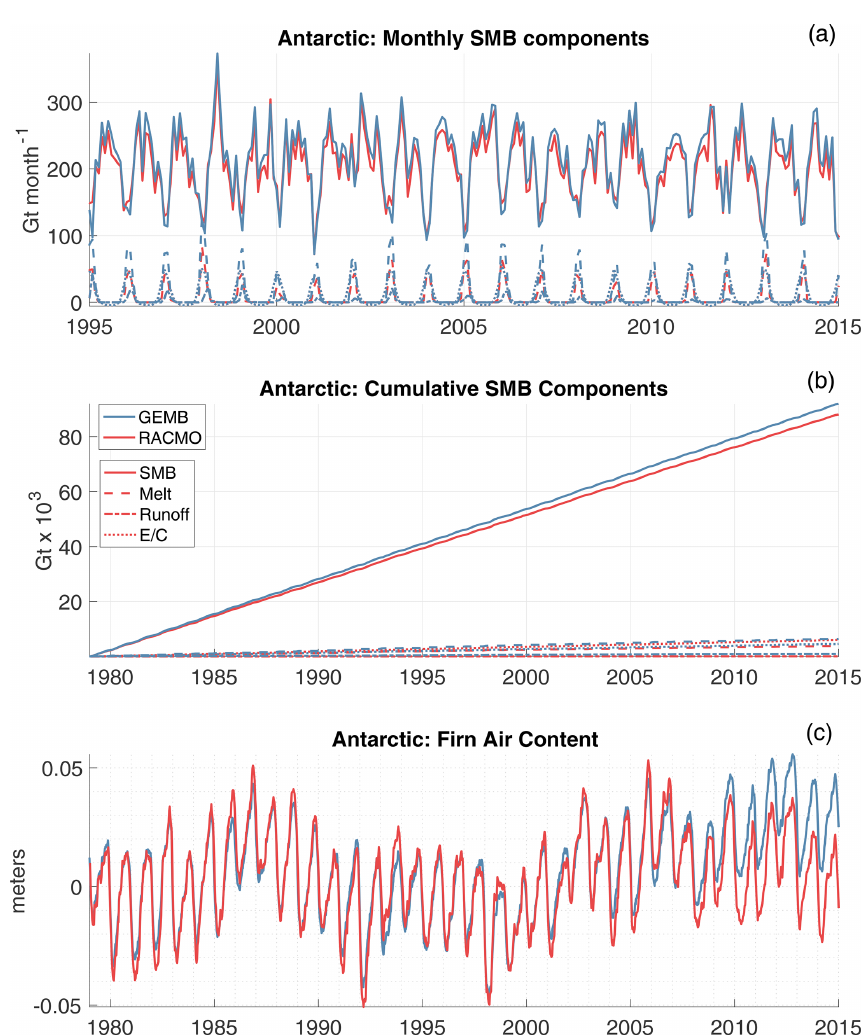
Figure 9. The 1979–2014 Antarctic Ice Sheet GEMB (blue) and RACMO (red) monthly (a) and cumulative (b) model output. GEMB (blue) and IMAU-FDM (red) average fin air content anomaly, relative to 1979, is shown in panel (c) . E/C is the mass change due to evaporation, condensation, sublimation, and